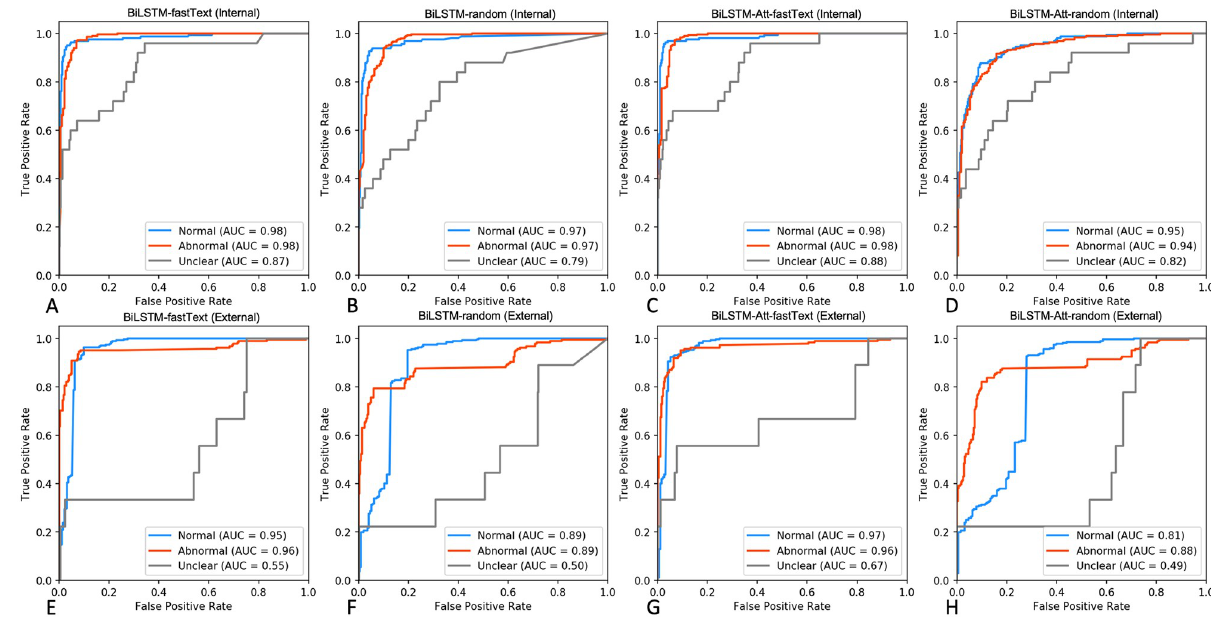
Fig 4. Performance assessment of BiLSTM classifiers on internal and external testing sets. A-D. ROC curves displaying performance metrics on an expert-labelled internal testing set (n = 329 Normal, n = 601 Abnormal, n = 35 Uncertain). E-H. ROC curves demonstrating classifier performance on the external MIMIC-CXR expert-labelled free-text reports (n = 272 Normal, n = 184 Abnormal, n = 9 Uncertain).